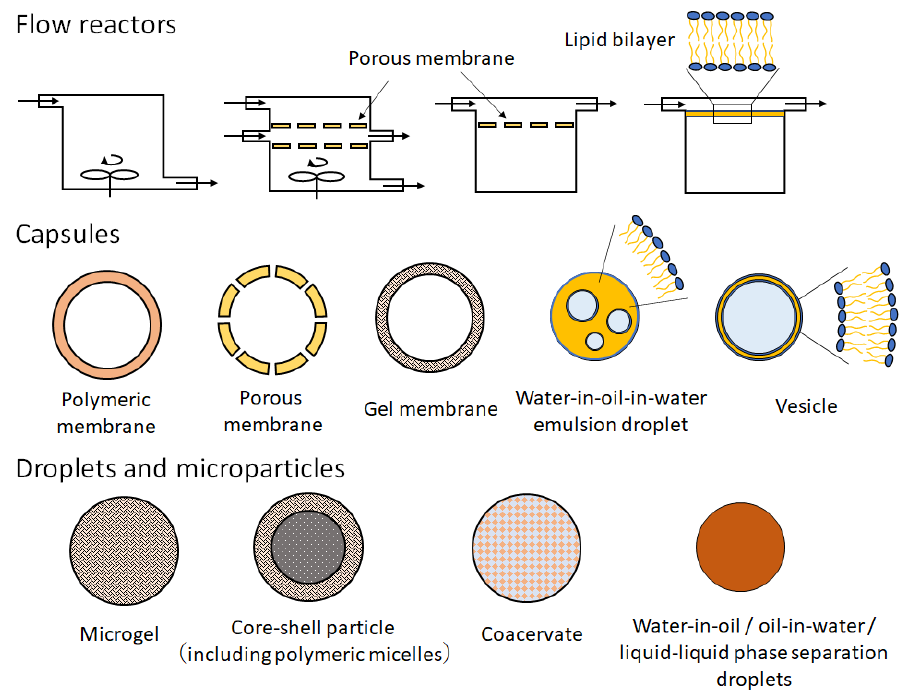
Figure 1. Schematic illustration of micrometer- and submicrometer-sized arti fi cial cells.